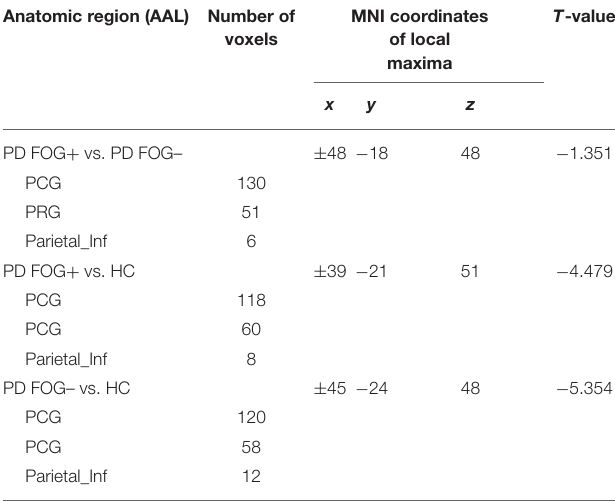
TABLE 2 | VMHC differences among PD FOG + and PD FOG–patients and HCs. Anatomic region (AAL) Number of